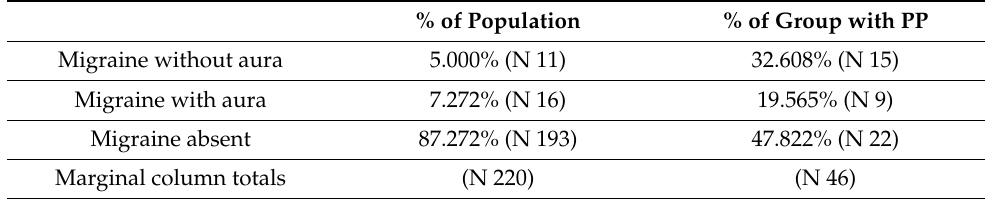
Table 1. Evaluation of PP and migraine in participants.